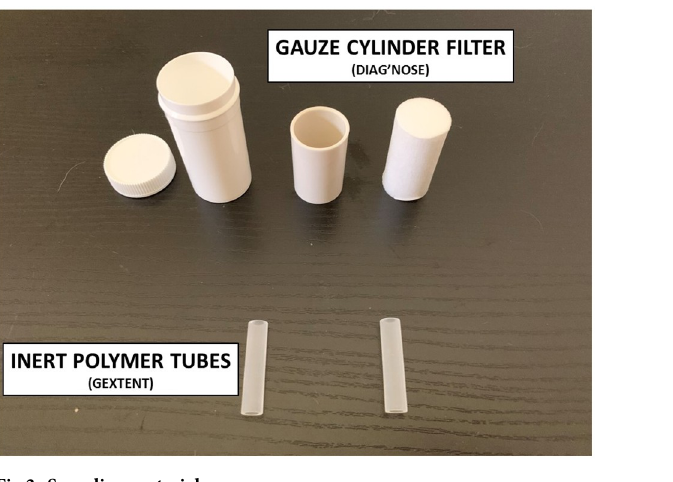
Fig 3. Sampling materials.